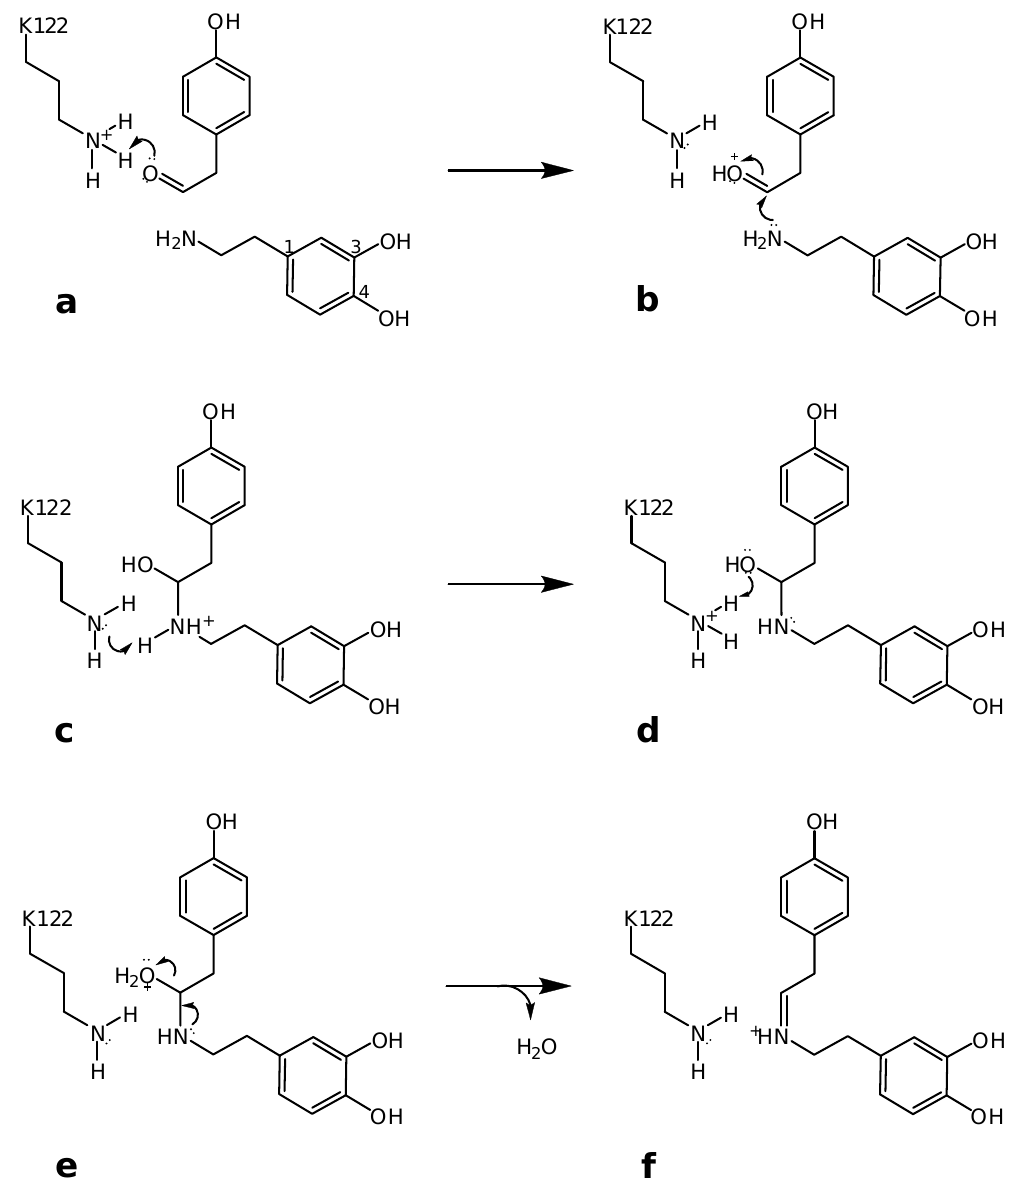
Scheme 2. Mechanism of NCS catalyzed iminium ion formation as intermediate in (S)- norcoclaurine